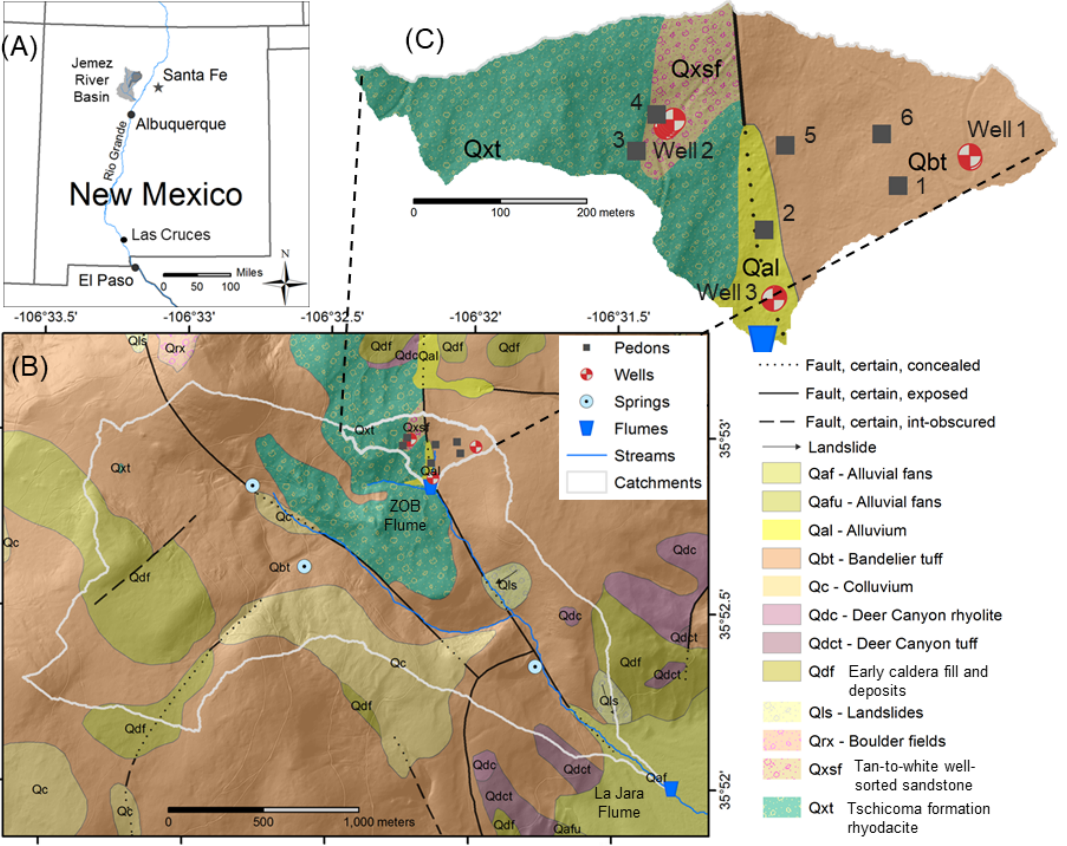
Figure 1. (a) The Jemez River Basin Critical Zone Observatory (JRB-CZO) is located on the Valles Caldera National Preserve (VCNP) in northern New Mexico, north of Albuquerque. (b) Notice the geologic complexity of La Jara catchment and the zero-order basin (ZOB) and the location of surface water flumes and springs. (c) Note the different geology of the three well sites, the location of the soil pedons in relation to the wells, and the fault at the site 3 well. Rock types beginning with the letters “Qx” are associated with breccia deposits (Goff et al.,